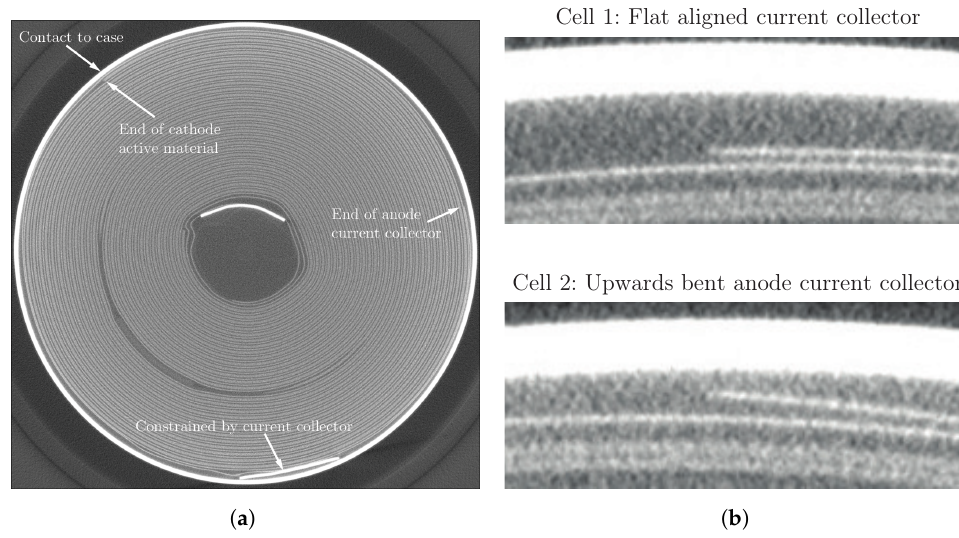
Figure 5. CT analysis of geometrical influences on the jelly-roll gap. ( a ) CT scan of the bottom cross-section of a Samsung INR18650-25RM cell (Cell 1) showing mechanical constraints on the jelly roll caused by contact with the case at the end of the jelly-roll winding and by the current collector tab. ( b ) Differences in the endings of the anode current collectors for Samsung INR18650-25RM Cells 1 and